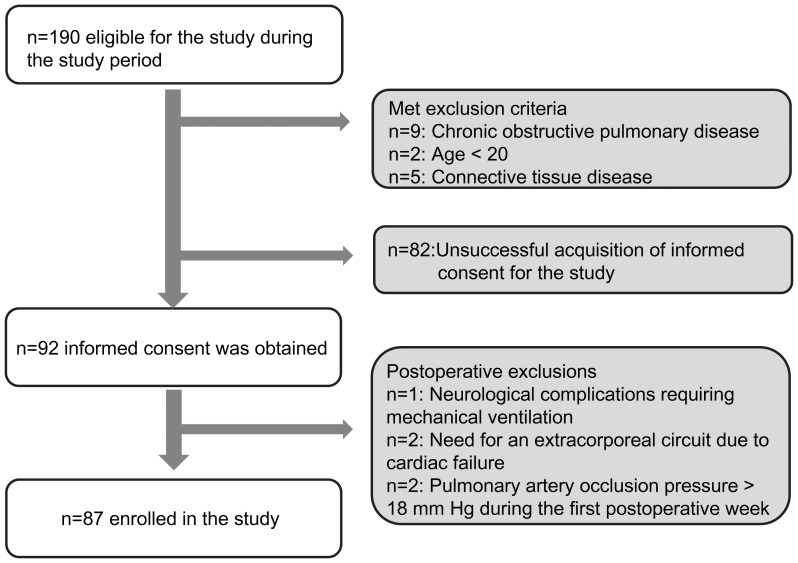
Flow chart for the enrollment of patients.